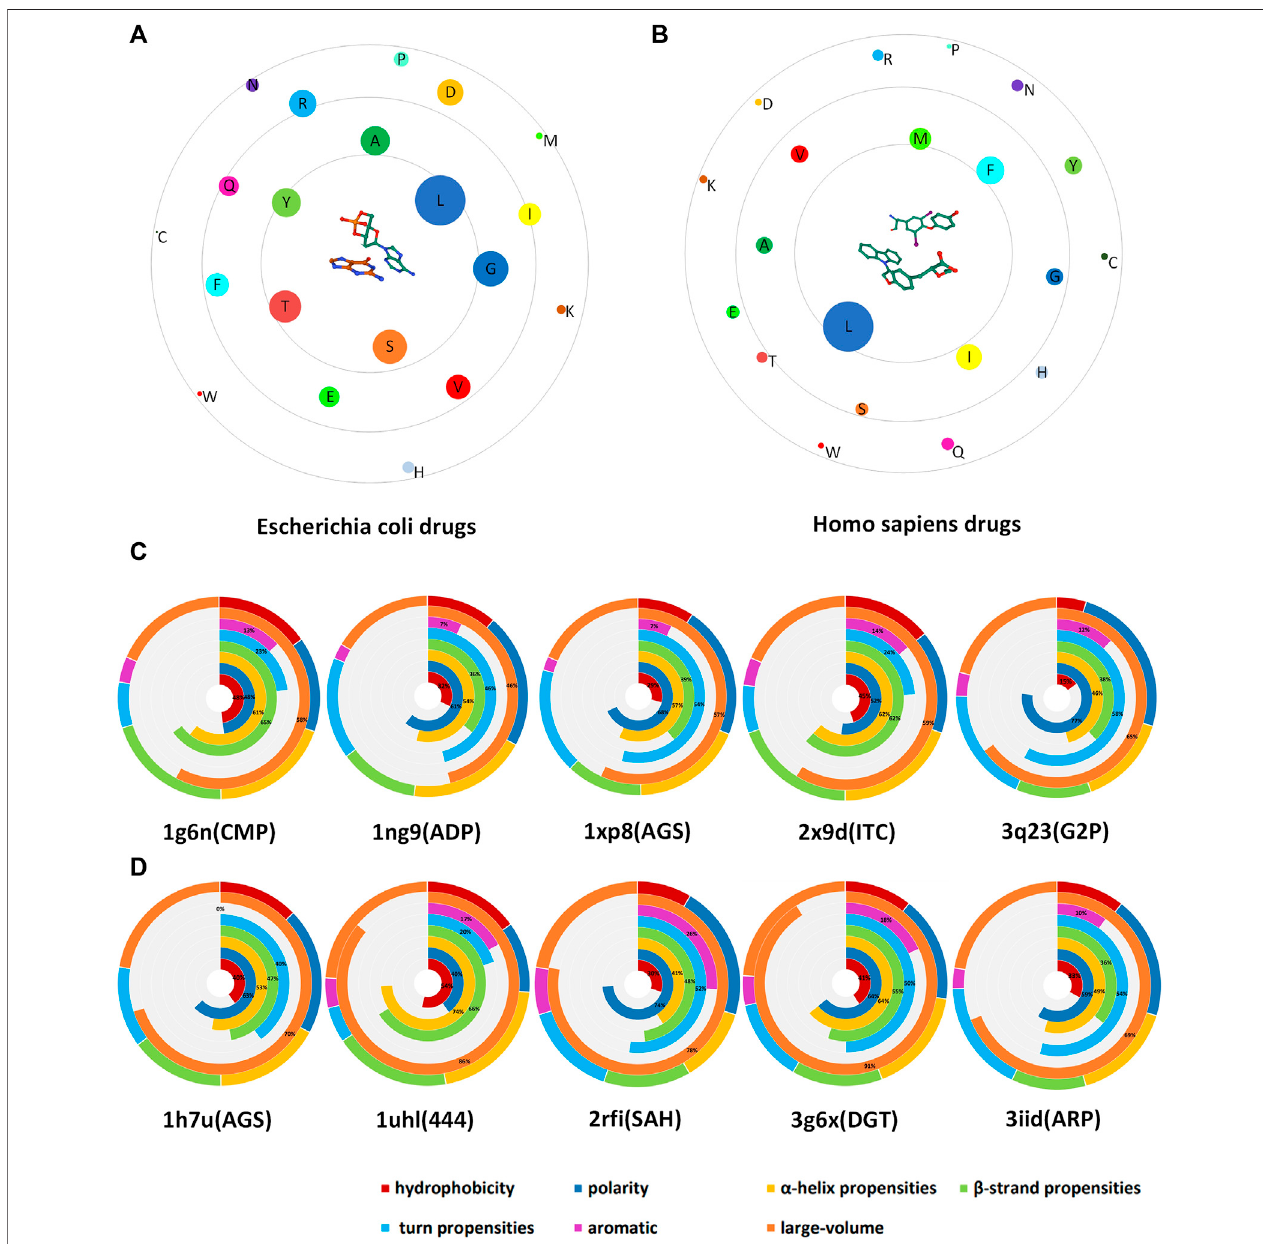
FIGURE 5 | Schematic diagram of drug-binding amino acid preferences. (A) is the drug ligand of Escherichia coli ; (B) is the drug ligand of homo sapiens. In the fi gure, the drug islocated in the center, and the binding site residues are distributed around, and we used circles ofdifferent sizes and colors toindicate the number and type of amino acids. (C) is the case of Escherichia coli drug-associated protein; (D) is the case of Homo sapiens drug-associated protein. Different colors are used to indicate the proportion of the characteristics.